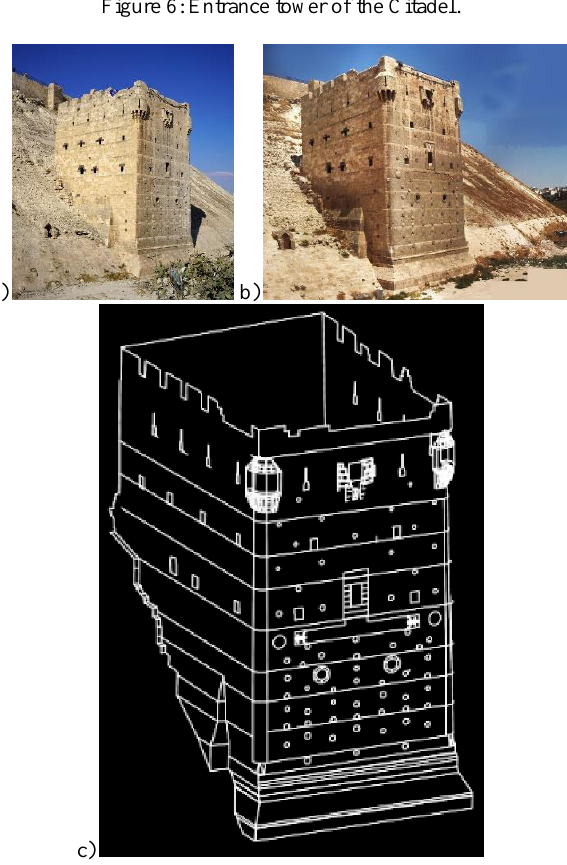
Figure 7: The Southern tower of the Citadel now (a), as it was (b) and a 3D restitution (c), by Oma